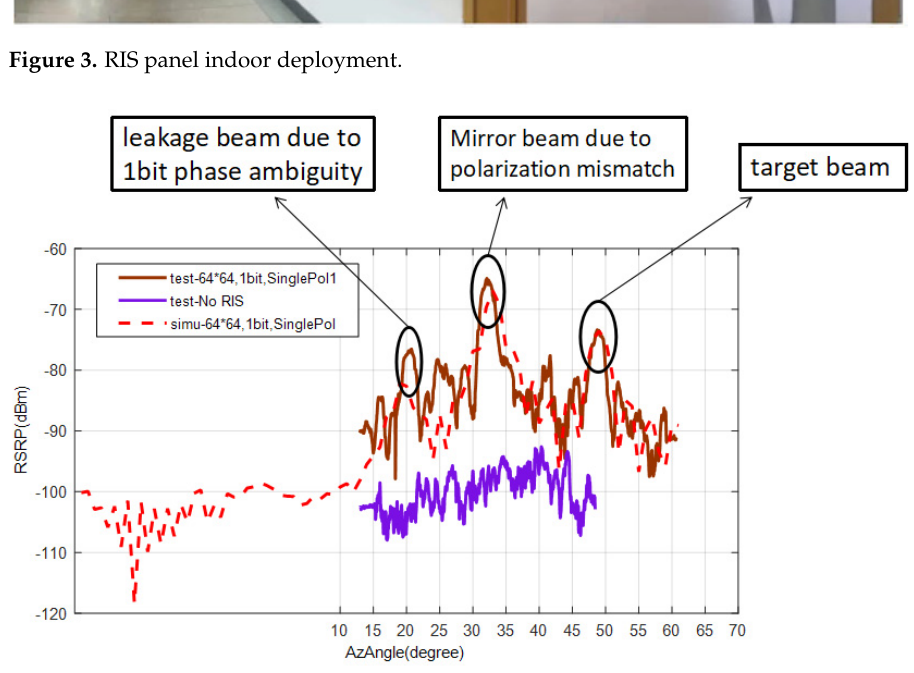
Figure 4. Comparison of the measured and simulated results of the 1-bit single-polarized panel.